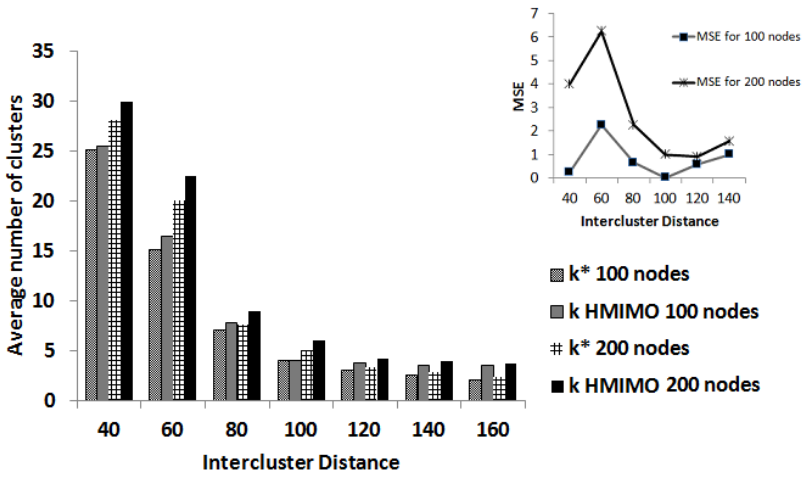
Figure 3. Number of